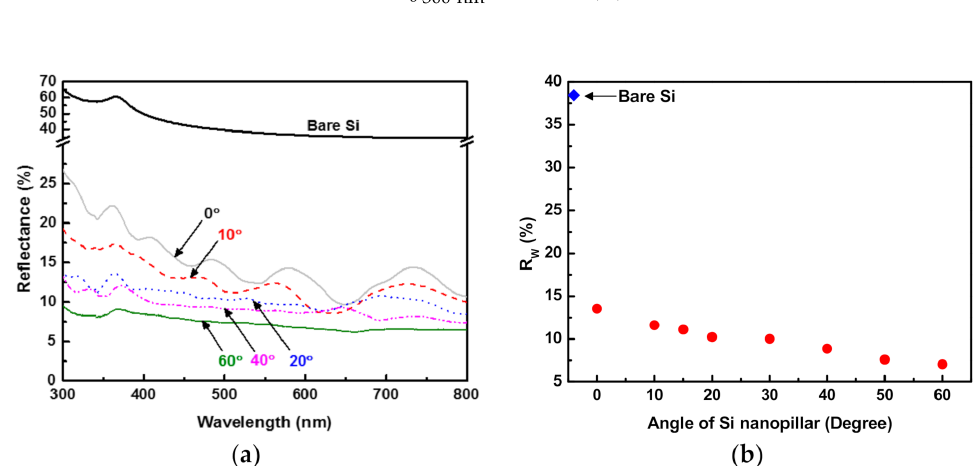
Figure 5. ( a ) Optical reflectance of Si substrates periodically arrayed with nanopillars at various angles; ( b ) weighted mean reflectance of Si substrates with periodically arrayed nanopillars as a function of their angles. In both figures, the values of bare Si are included for